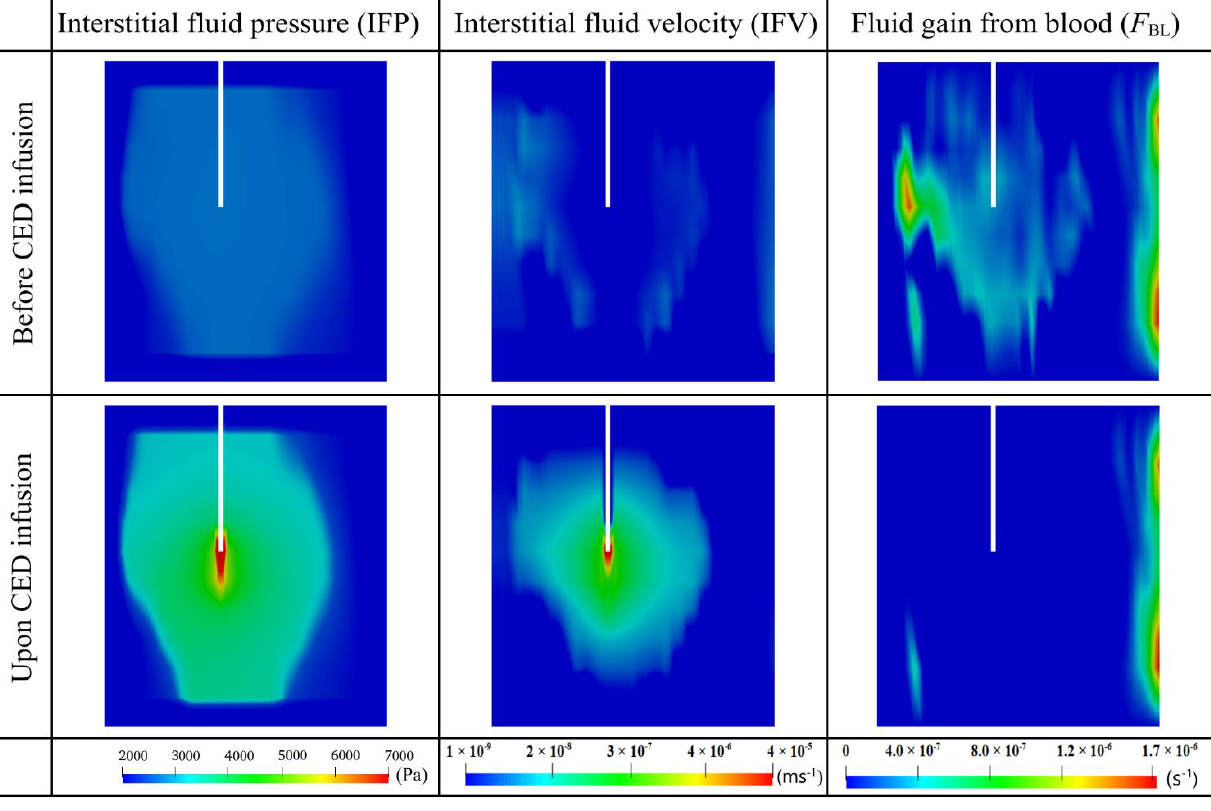
Figure 9. The distribution of interstitial fluid flow and fluid gain from the blood before and after the combined CED infusion. Results in the upper and lower panels are taken at time zero and Day 3, respectively.